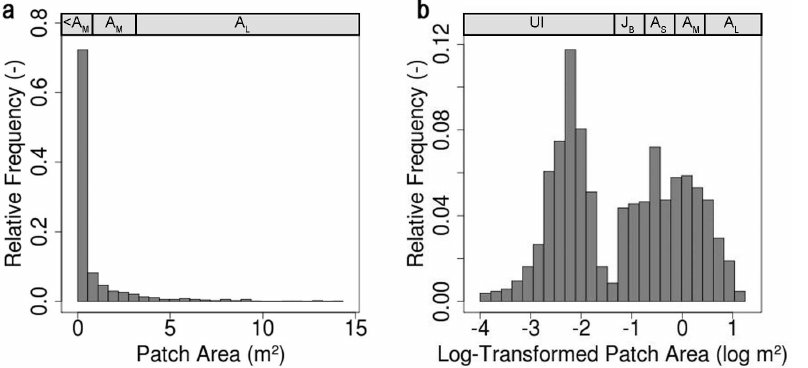
Figure 4. Histograms with 25 bins of R.stricta patch (a) surface areas and (b) log-transformed surface areas. Size classes (assumed cohorts) of unbranched individuals (UI), branched juveniles (J B ), small adults (A S ), medium adults (A M ), and large adults (A L ) are depicted inside the histograms, where possible. However, due to lack of space in the left histogram, size classes smaller than A M are joined together (denoted as , A M ).